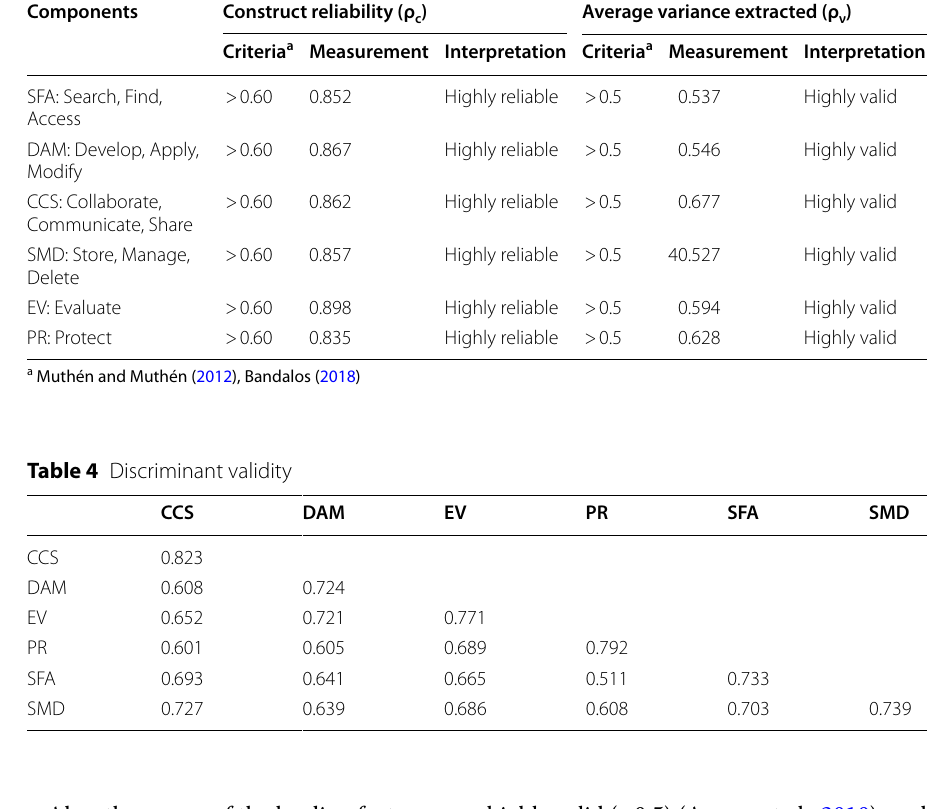
Table 3 Reliability, validity, and internal consistency of the PLS-SEM measurement model Components Criteria a Measurement Interpretation Criteria a Measurement Interpretation